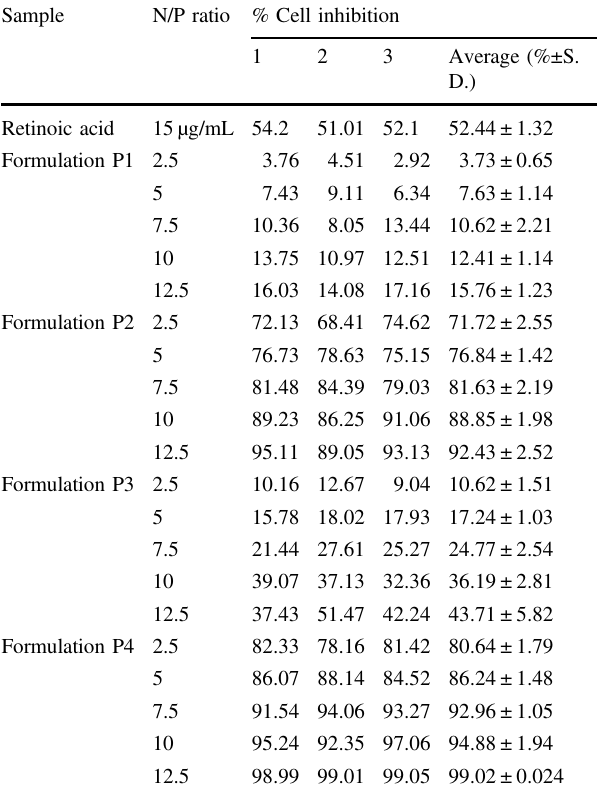
Table 3 ll inhibition by drug and different formulations P1, P2, P3 and P4 at different concentrations